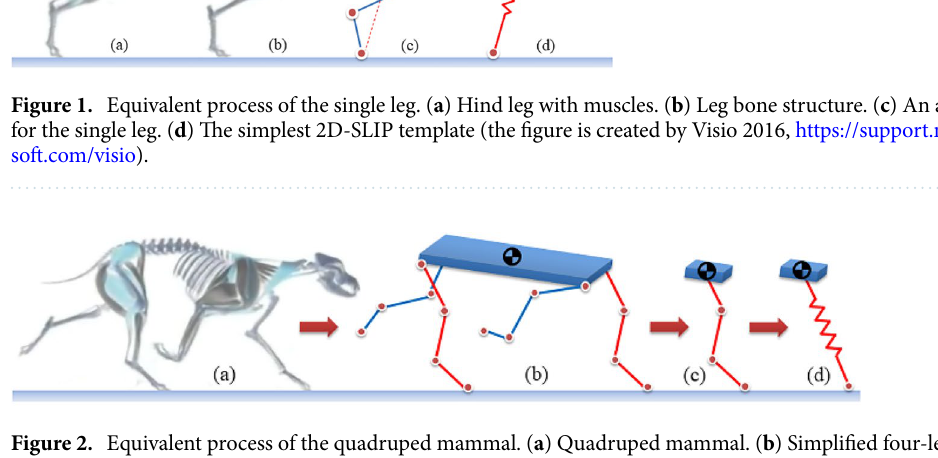
Figure 2. Equivalent process of the quadruped mammal. ( a ) Quadruped mammal. ( b ) Simplified four-legged model. ( c ) An anchor for the equivalent virtual leg. ( d ) The simplest 3D-SLIP template (the figure is created by Visio 2016, https:// suppo rt. micro soft. com/ visio).